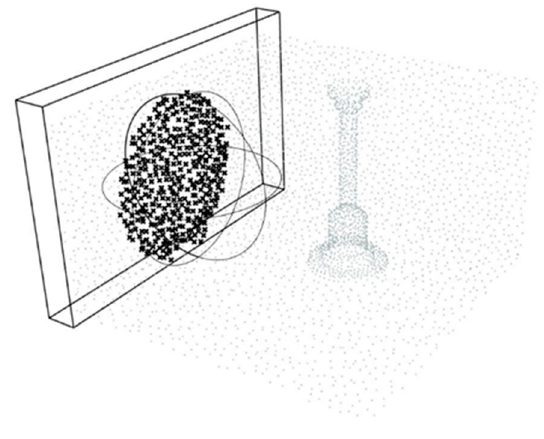
Figure 6. Subset with a sphere and extrusion object.